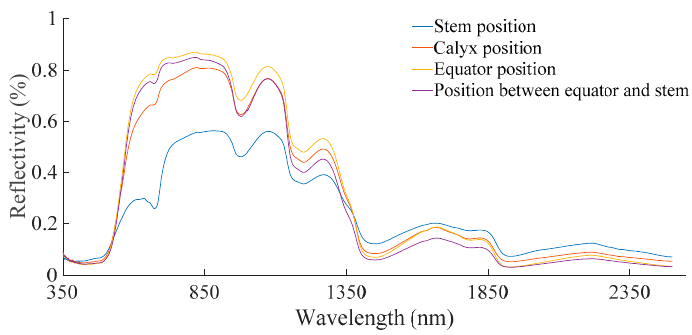
Figure 1. Average of spectral response of different positions on orange.